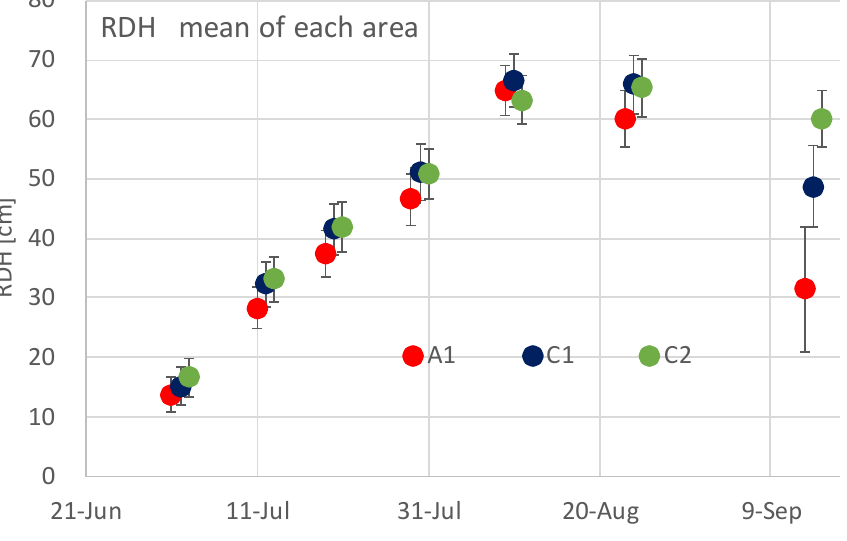
Fig.12 Time-series changing of